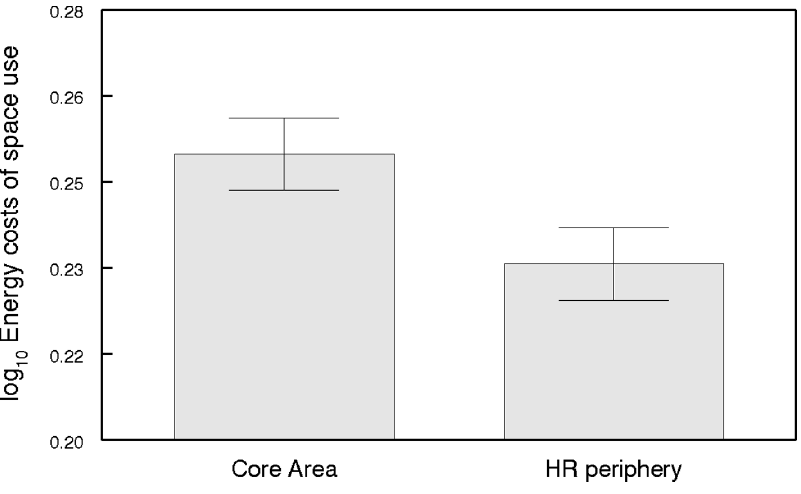
Figure 2. Energy costs of space use within the CA and the HR periphery. Adjusted means are from log 10 transformed data.